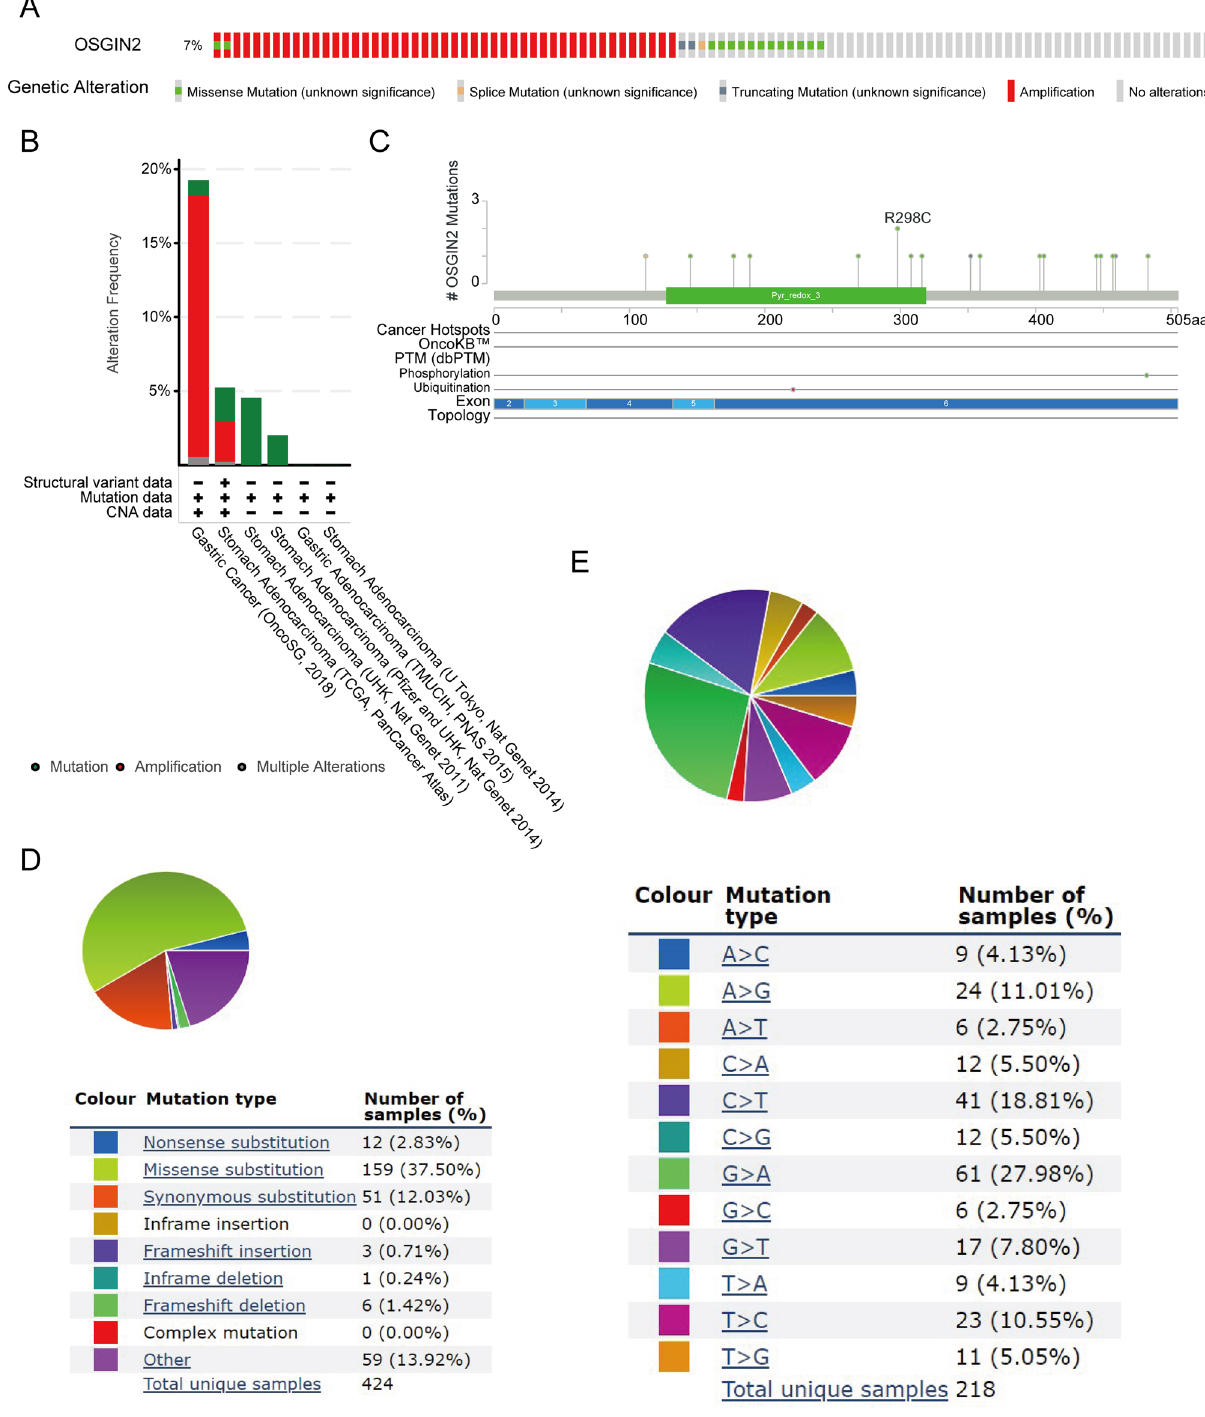
Figure 6. Mutation information of OSGIN2 in gastric cancer ( A , B ) Mutation frequency and mutation type of OSGIN2 in gastric cancer, assessed using the cBioPortal database. ( C ) Specific sites where OSGIN2 is mutated and specific sites of phosphorylation and ubiquitination in GC patients. (D,E) Mutation types of OSGIN2 assessed in the COSMIC